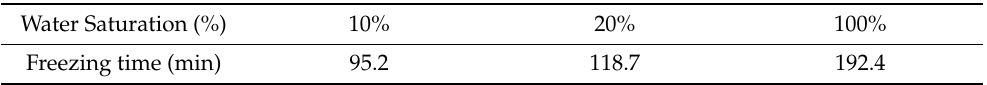
Table 3. Time taken for the temperature of D4 to drop to − 4 ◦ C under different water saturation conditions. Water Saturation (%) 10% 20% 100% Freezing time (min) 95.2 118.7 192.4 A fitting curve of the time taken for the D4 temperature to drop to − 4 ◦ C